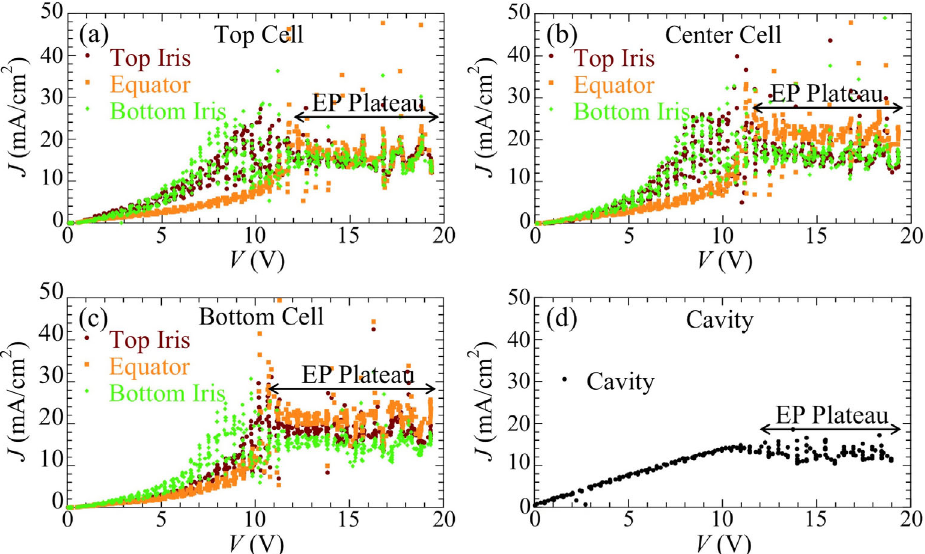
FIG. 17. Polarization ( J (cid:1) V ) curves measured for the coupons in the top cell (a), center cell (b), bottom cell (c), and the cavity (d). Cathode rotation of 20 rpm and the optimized dual-flow condition were set during the measurement. The cavity temperature was uniformly maintained at ∼ 15 °C.